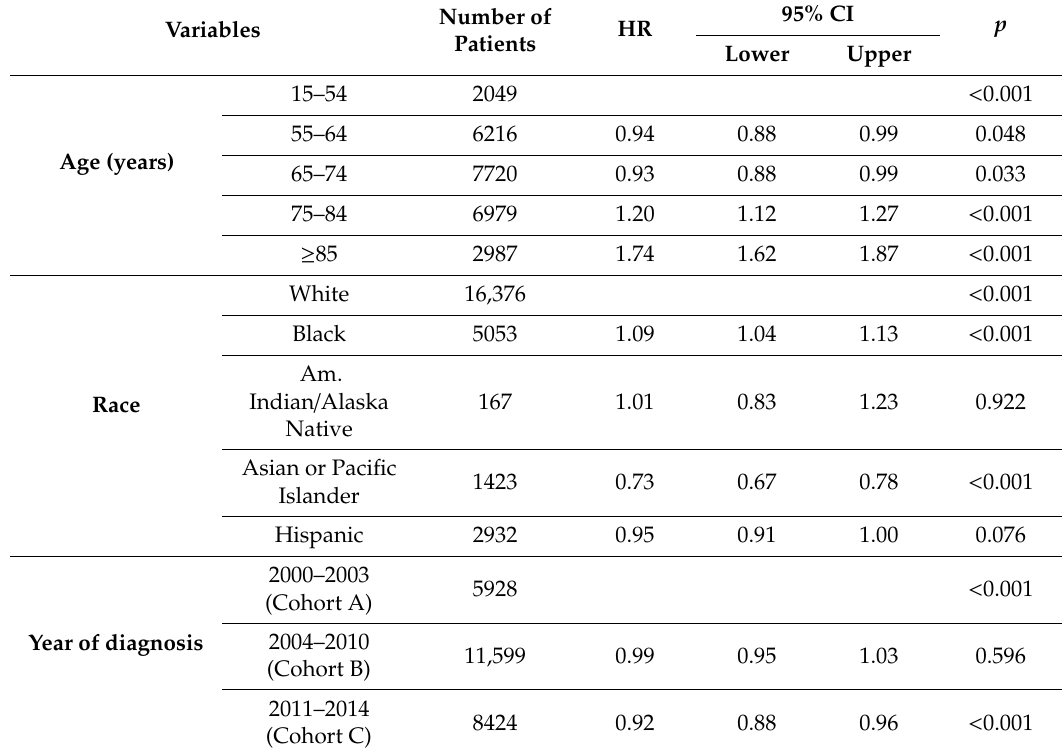
Table 3. Multivariable analysis for